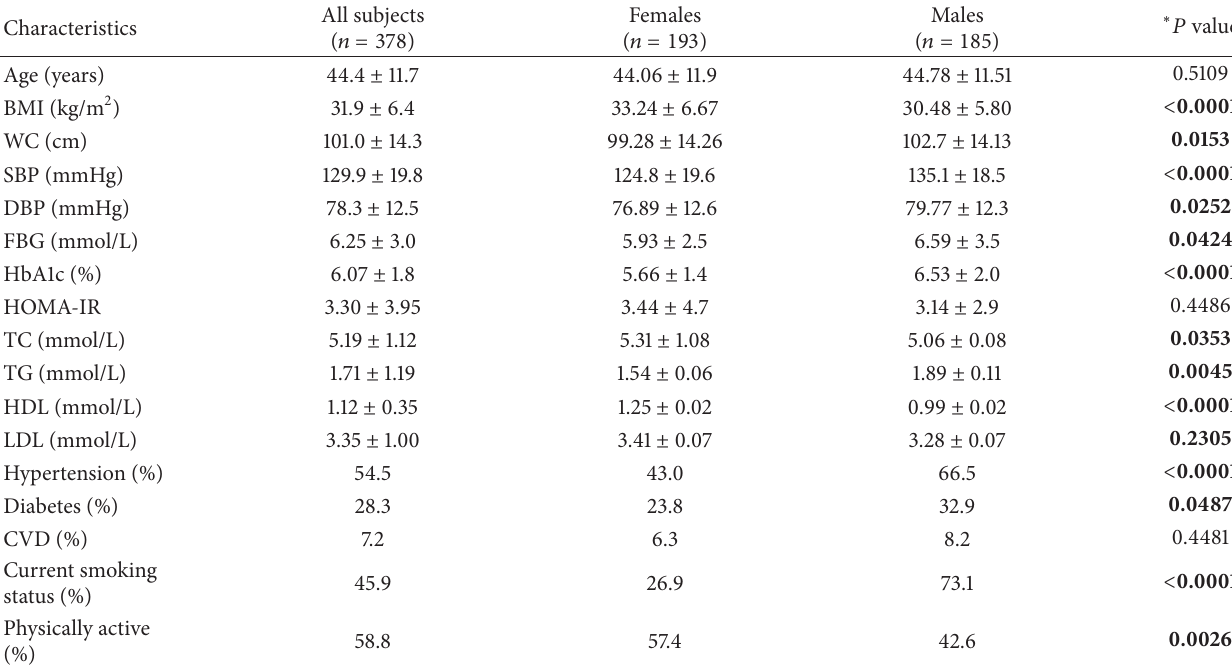
Table 1: Anthropometric and clinical characteristics of the Arab population study.